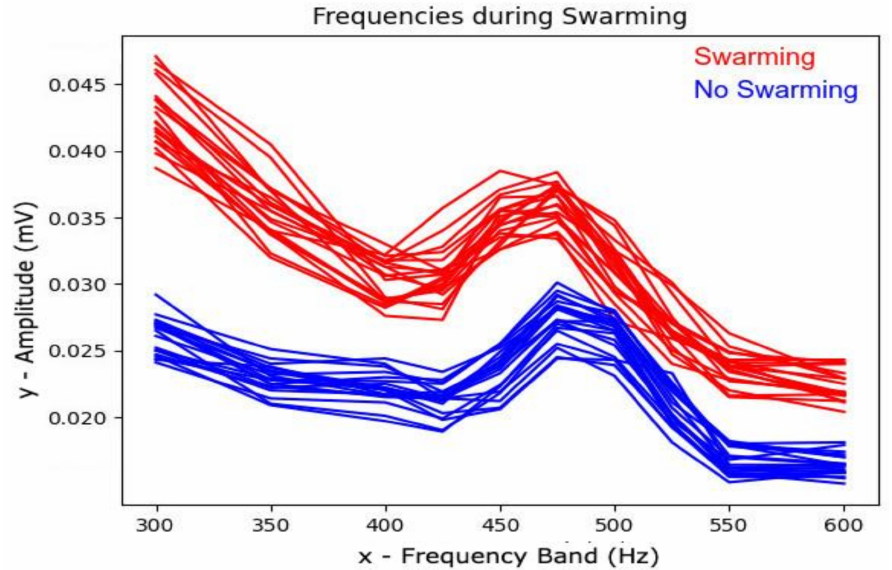
Figure 5. Amplitude response in mV RMS, 5 days before the swarming event over the frequency band of 300–600 Hz (using 10/25 Hz frequency bins).